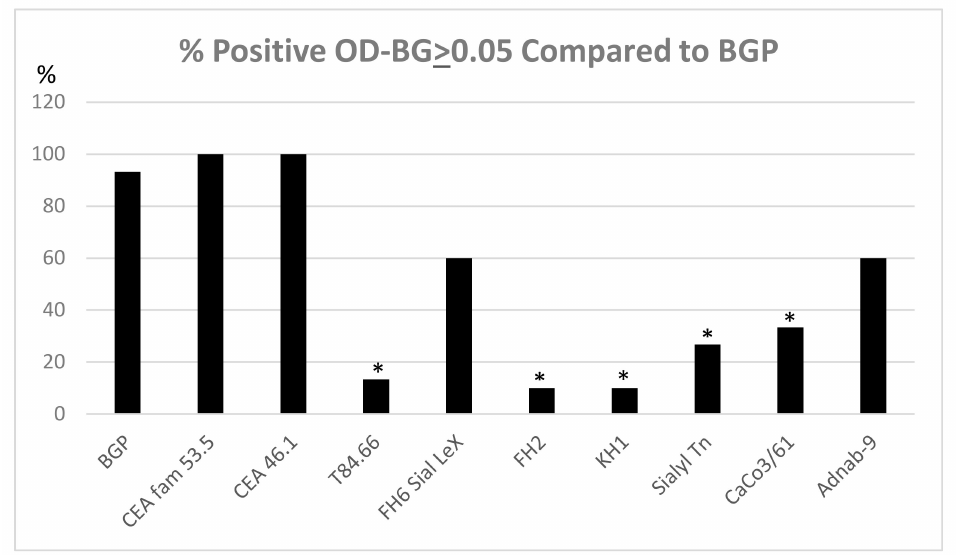
Figure 8. Expression of tumor metastasis associated antigens in tamarin and marmoset colonic